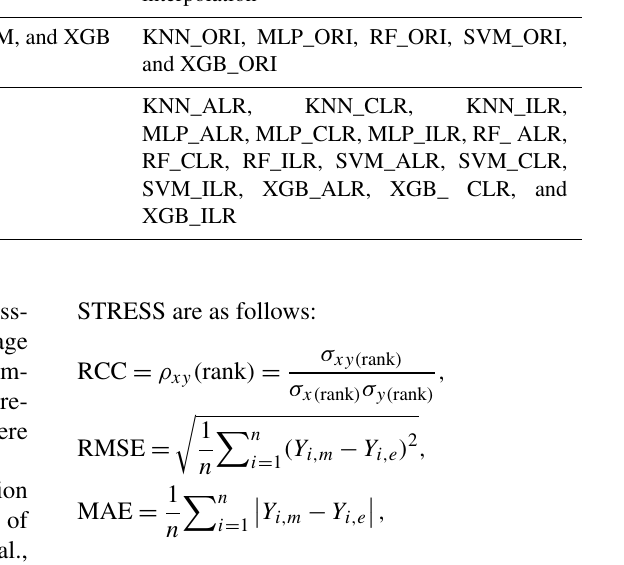
Table 1. The method system of soil texture classification and soil PSF interpolation. Transformation methods Soil texture classification (direct) Soil texture classification (indirect) & soil